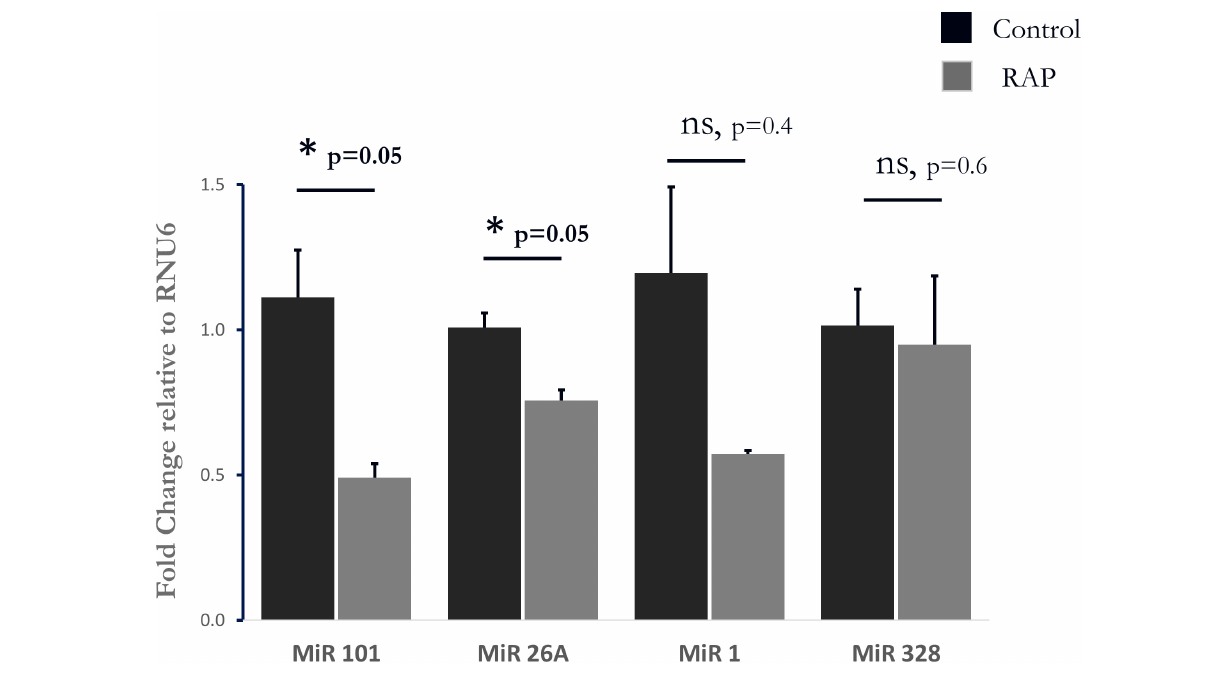
Frontiers in Physiology |